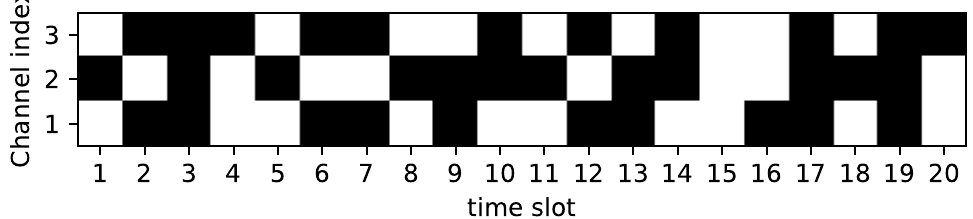
Figure 2. A capture of a multiple channel